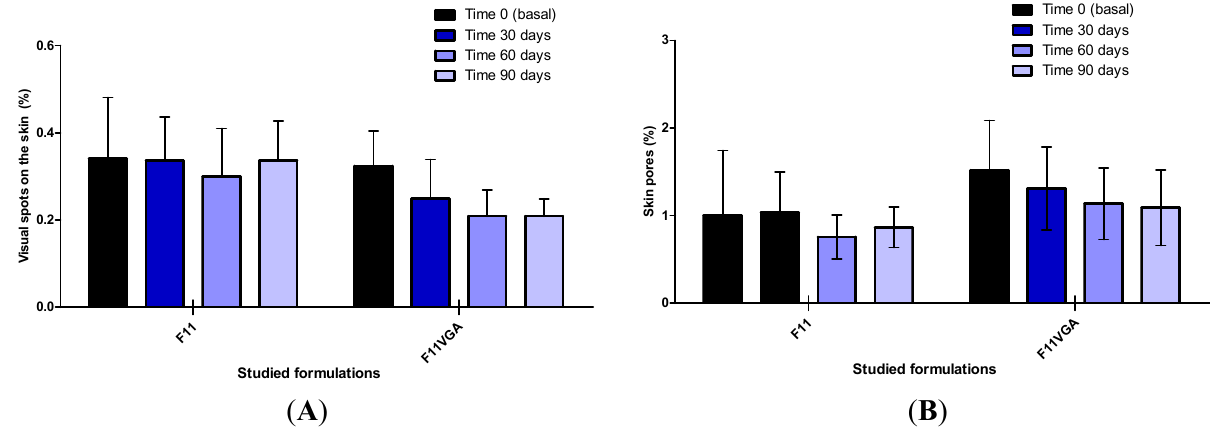
( C ) * : Statistically different from baseline. Figure 3. Mean percentage and confidence interval 95% (CI95%) of visual spots ( A ) and skin pores ( B ) achieved on the face of volunteers after 30, 60 and 90 days of daily application of studied formulations (N = 45